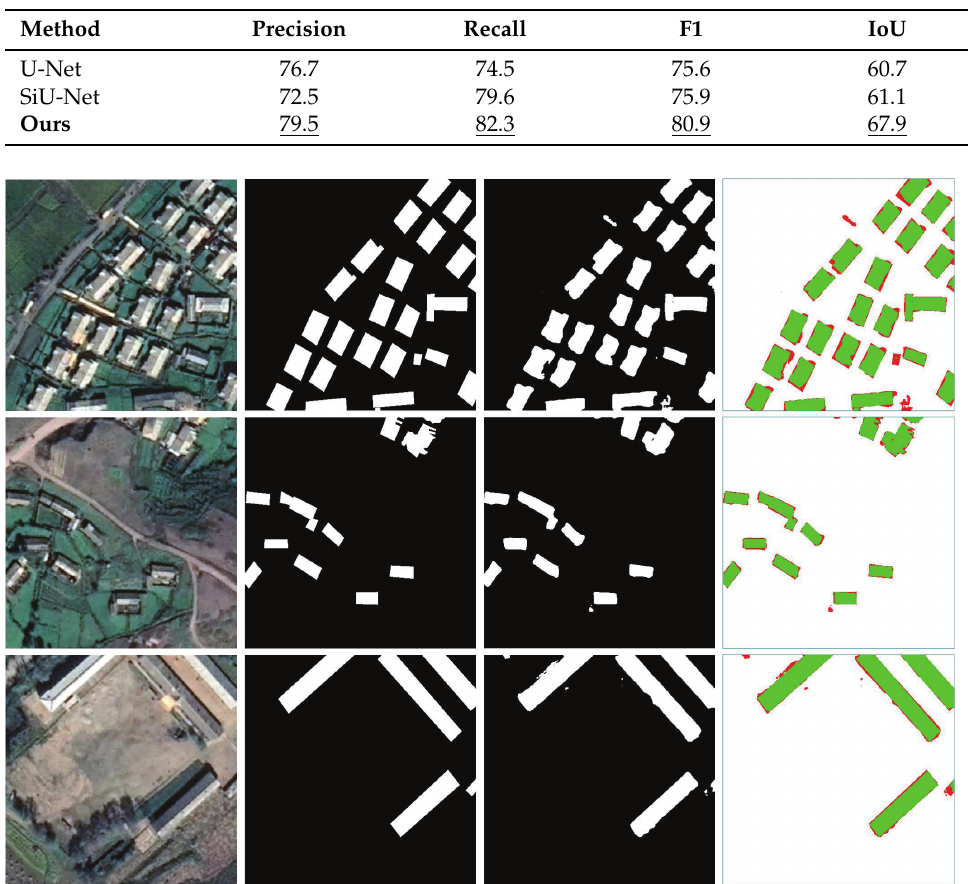
Table 4. Quantitative evaluation (%) and comparison on the WHU Satellite Building Dataset II (SiU-Net [5] is the official method provided by this dataset; the highest values are underlined).